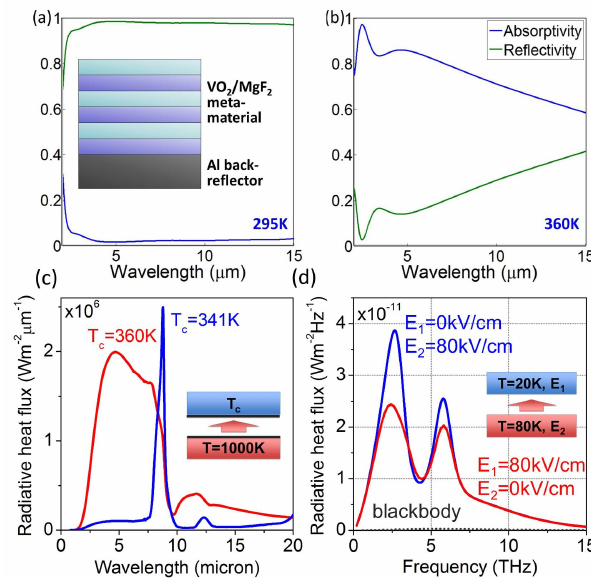
Fig. 11. Dynamic tunability of thermal emission. (a, b) Absorp- tance/emittance spectra of a metamaterial structure composed of VO 2 , MgF 2 , and an Al back reflector. At low temperatures, the struc- ture acts as a mirror (a), while at high temperatures, it becomes an eflcient broadband emitter (b). (c) The near-field heat flux spectra as a function of wavelength between 2 nm-thin VO 2 films on SiO 2 substrates at an emitter temperature of 1000 K and an absorber temperature either at 360 K (red line) or 341 K (blue line) [72]. The emitter and absorber are separated by a 20 nm gap. (d) Simulated radiative heat flux between ferroelectric materials for a 100 nm gap between hot and cold surfaces [260]. Magnitude of spectral heat flux is modulated via external electric